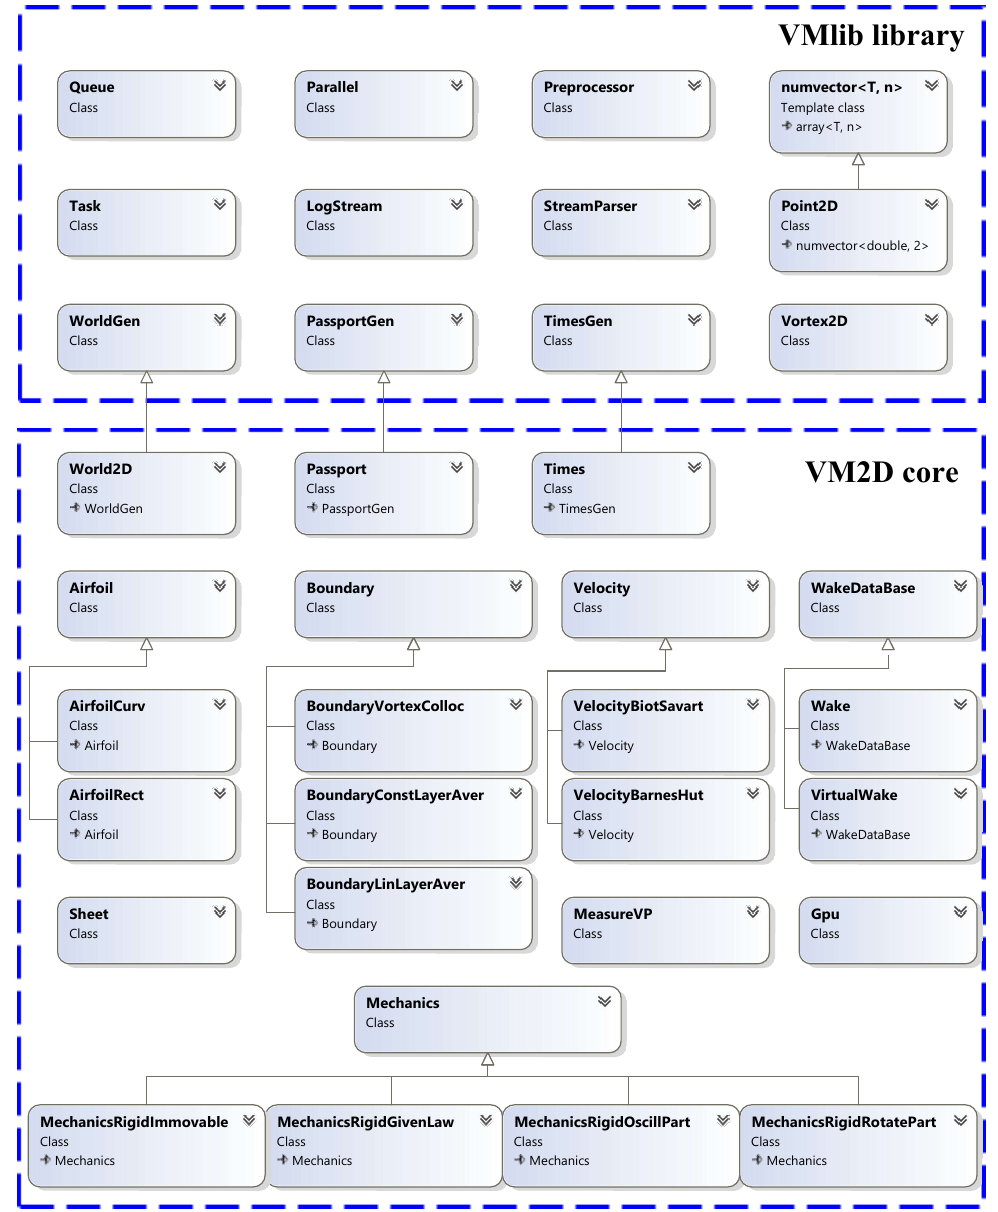
Figure 11. Class diagram for VMlib library and VM2D